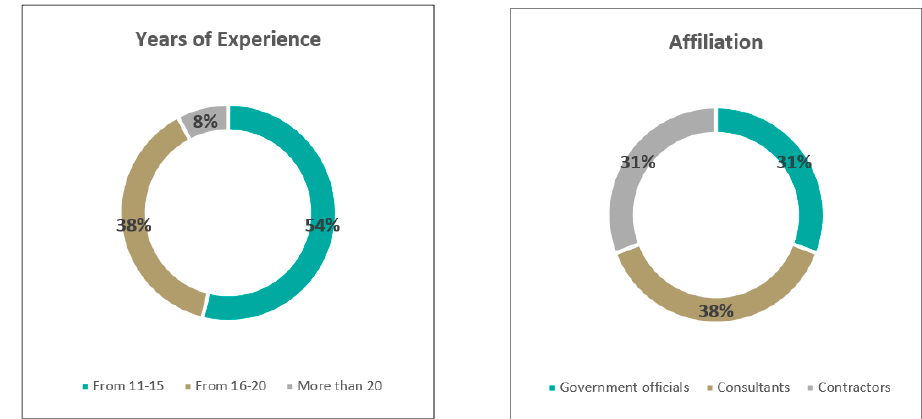
Figure 3. The experts’ panel profile.